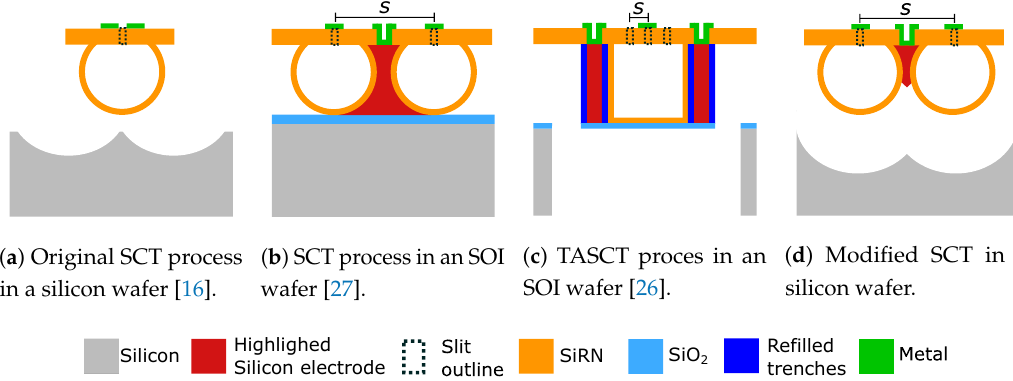
Figure 1. Schematic cross-sectional illustrations of four types of microchannels fabricated by four variations of the Surface Channel Technology (SCT) process. A microchannel made by ( a ) the original SCT process in a silicon wafer uses one row of slits (dashed lines) and uses thin film metal electrodes on top of the silicon–richsiliconnitride(SiRN) membranes for sensing or actuation functions. Microchannels made by ( b ) SCT process in an SOI wafer, ( c ) Trench-Assisted Surface Channel Technology (TASCT) process in an SOI wafer, and ( d ) modified SCT process in a silicon wafer all allow to embed the silicon electrodes (highlighted in red) onto the sidewalls of the microchannels. The dimension and location of the microchannels in ( b , d ) are determined by the spacing S between two rows of slits, and in ( c ) by the locations of the refilled